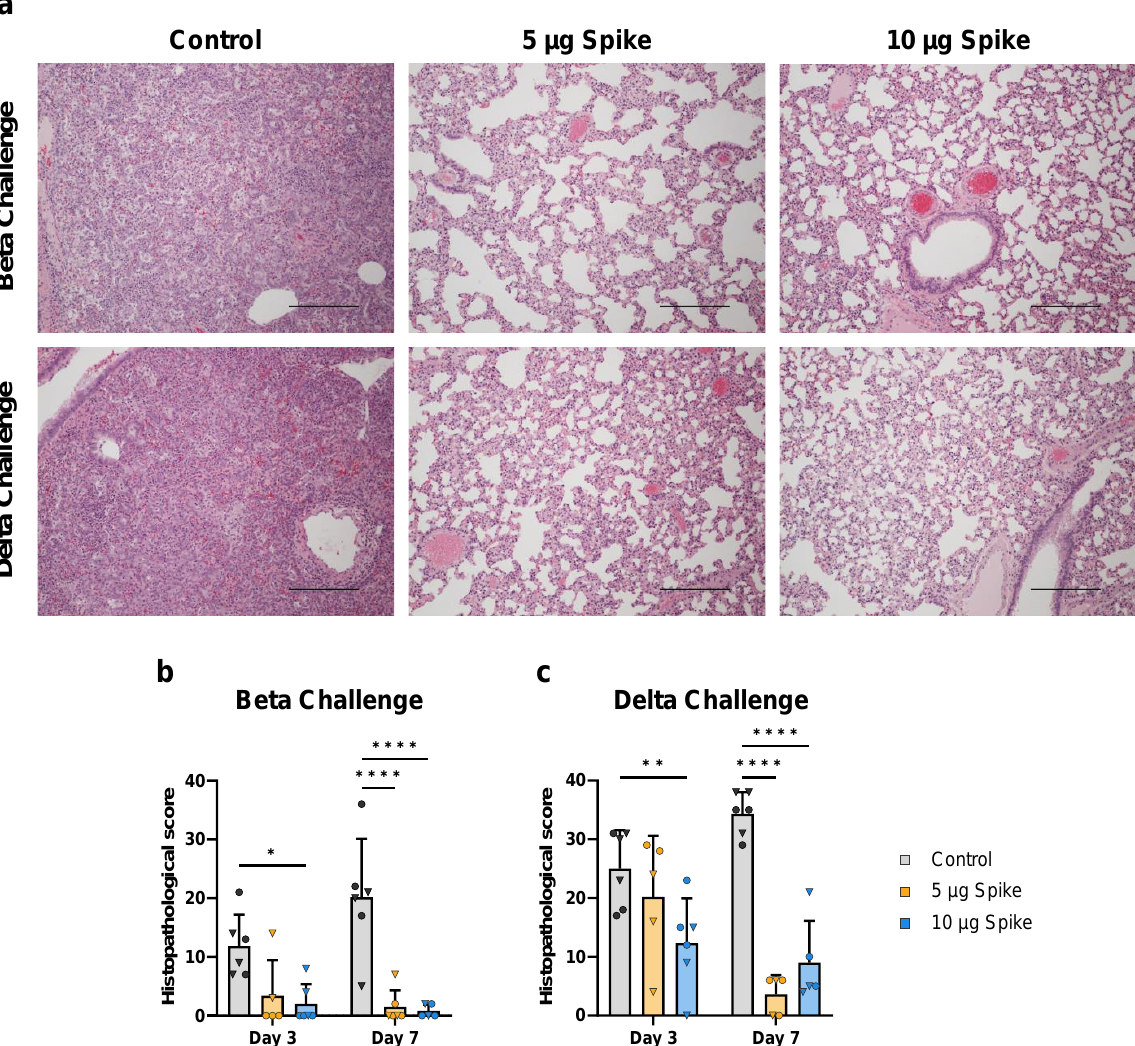
Figure 7. Lung histopathology at 3- and 7 days post challenge. ( a ) Representative micrographs of lungs from control and vaccinated animals 7 days post challenge with either the Beta or Delta variant of SARS-CoV-2. Lungs of the unvaccinated (Control) animals are characterized by loss of normal lung architecture due to severe leukocyte infiltration in alveolar spaces and septae, presence of fibrin strands in alveoli, enlargement (hypertrophy) and proliferation (hyperplasia) of pneumocytes and variable hemorrhage in the parenchyma, resulting in loss of patent airspaces (left panels). In contrast, lungs of the vaccinated animals have no or minimal leukocyte infiltration regardless of vaccine dose and alveoli are patent (middle and right panels). Scale bars are 400 µ m. Histopathological scores were determined for hamsters challenged with the ( b ) Beta or ( c ) Delta variant. Scores for individual animals are presented as either circles ( • ) for females or triangles ( (cid:72) ) for males. Dotted line indicates lower limit of detection. Data are mean + SD. Results were analyzed by two-way ANOVA with Tukey’s multiple comparisons test, with p < 0.05 considered significant. * p < 0.05, ** p < 0.01, **** p <